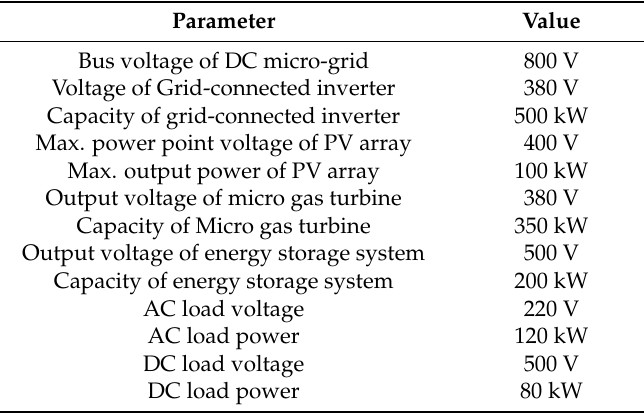
Table 1. System parameters.